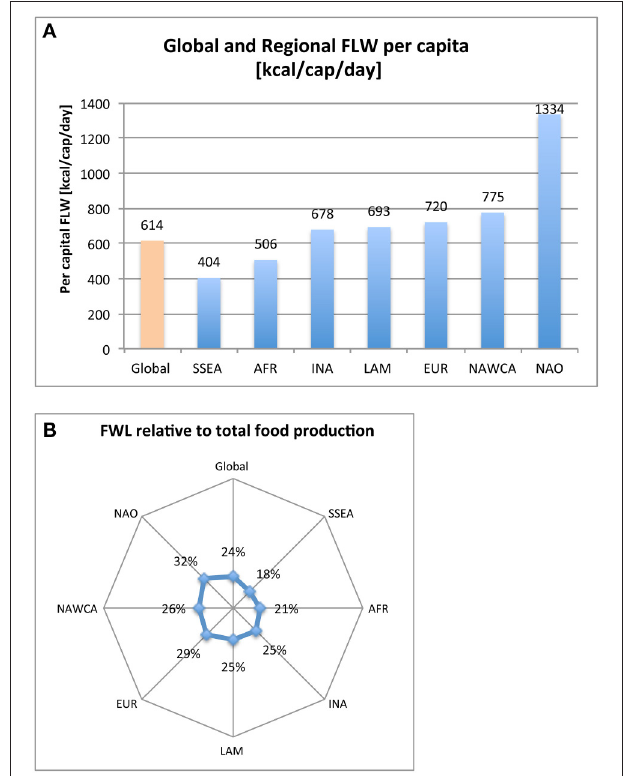
FIGURE 1 | Global and regional per capita FLW [kcal/cap/day] on a caloric basis (A) and FLW relative to total food production (B) . Source of data: (Kummu et al., 2012). AFR, Sub-Saharan Africa; EUR, Europe (including Russia); INA, Industrialized Asia; LAM, Latin America; NAWCA, North Africa and West-Central Asia; NAO, North America and Oceania; and SSEA, South and Southeast